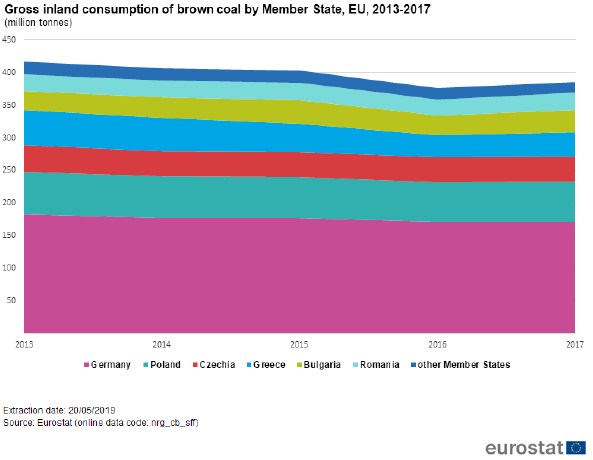
Figure 1. The combined production of heat and electricity by burning gas and the use of a microturbine is much more environmentally friendly than the combustion of coal for heat production.